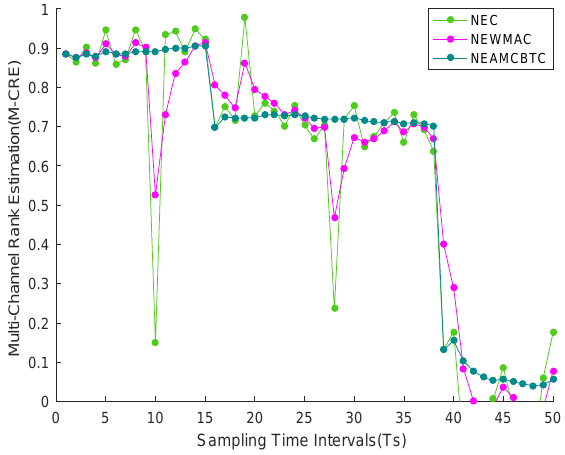
Figure 8. Channel abnormal behavior tracking and